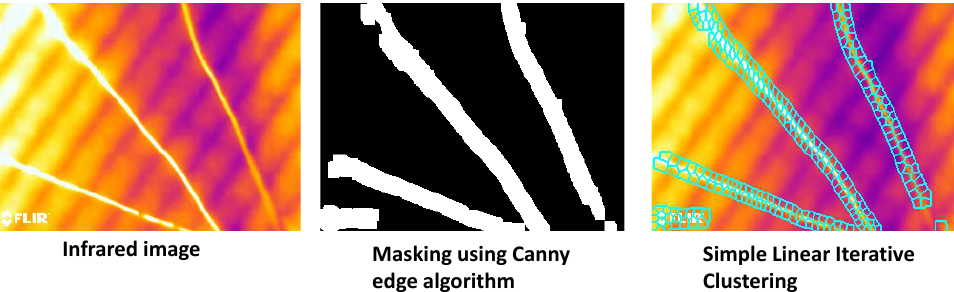
Figure 5. ( left ) An infrared image from heated wires, ( centre ) masked image using Canny edge detection algorithm, ( right ) image obtained using simple linear iterative clustering.